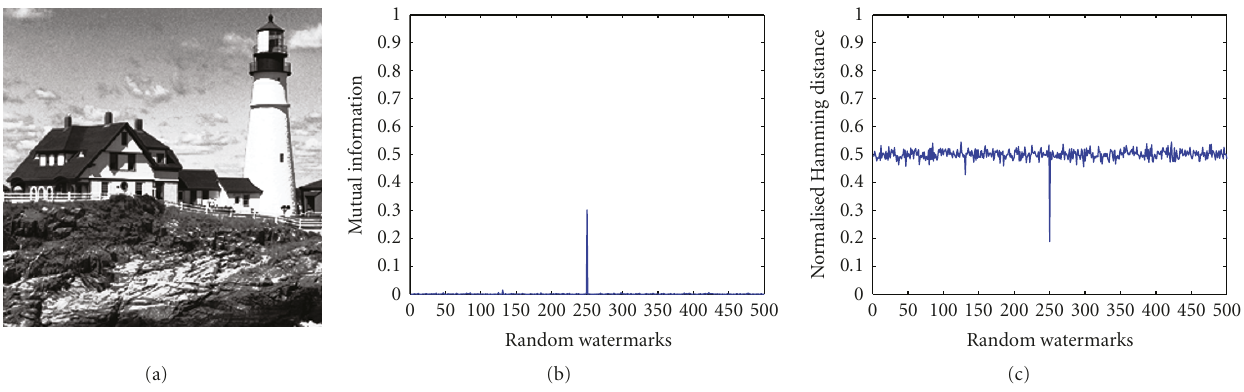
Figure 11: Equalization attack tested on a dictionary of 500 randomly generated watermarks: (a) green component after equalization attack; (b) mutual information; (c) normalized Hamming